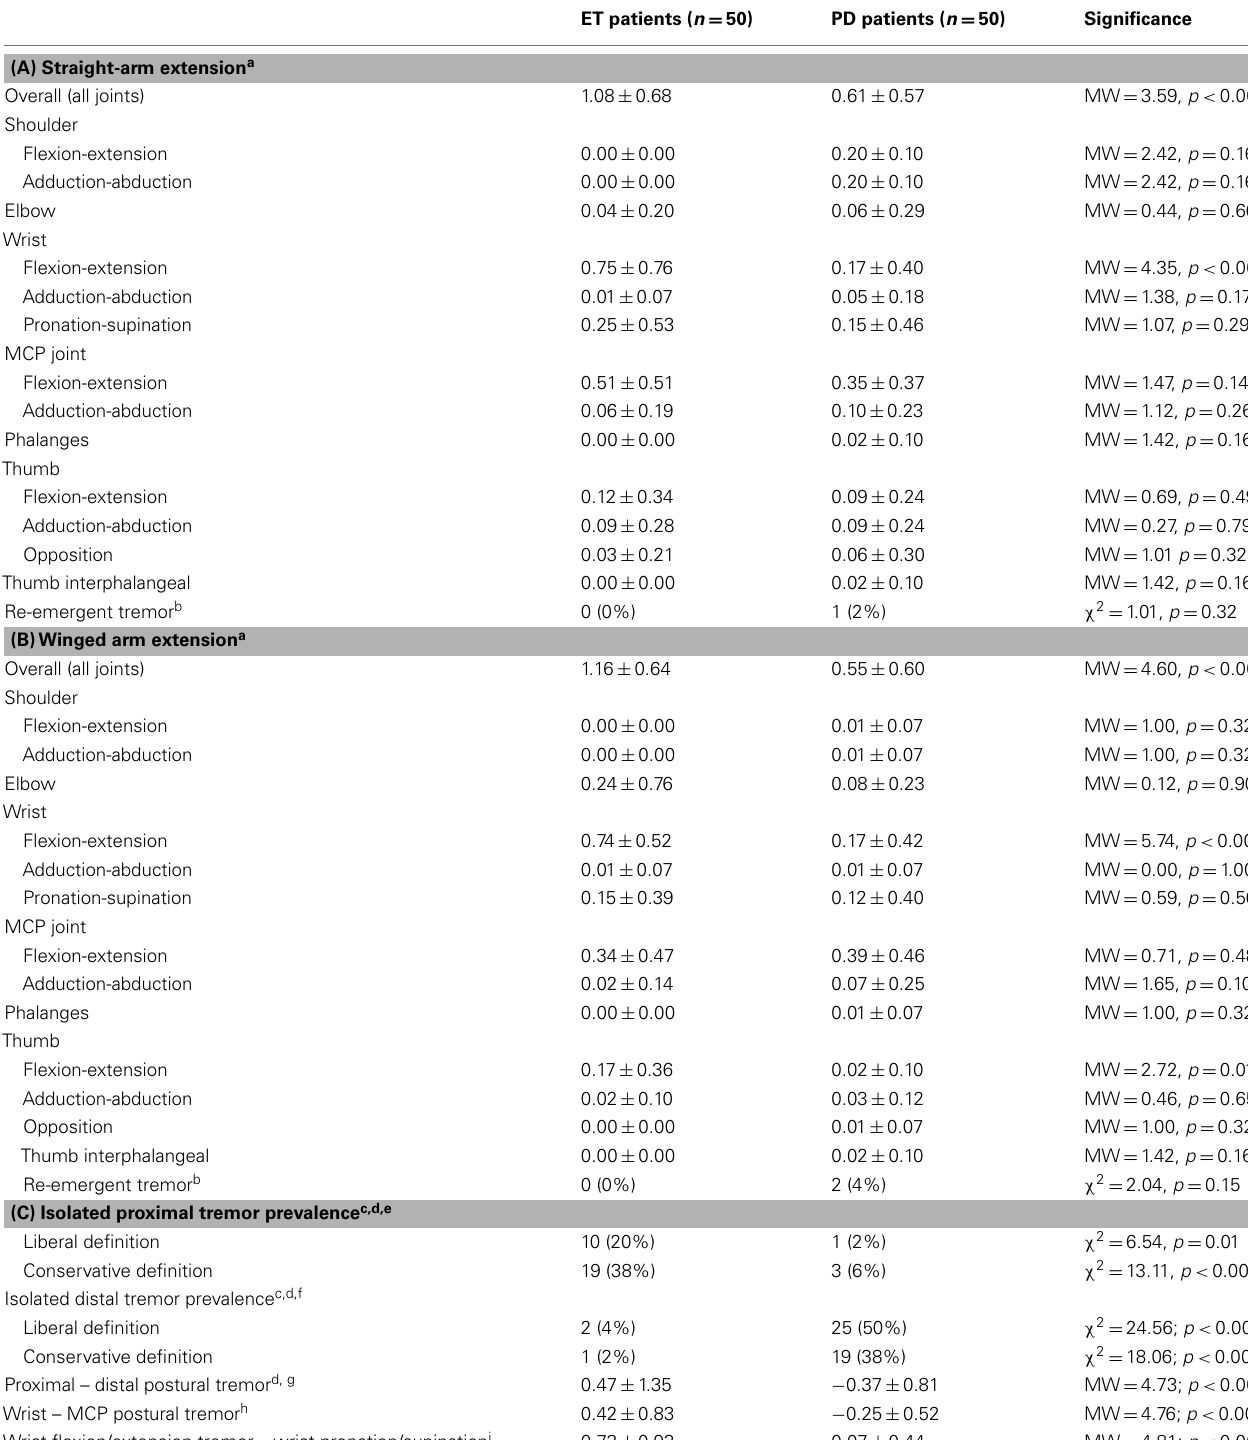
Table 2 | Clinical examination data for ET and PD